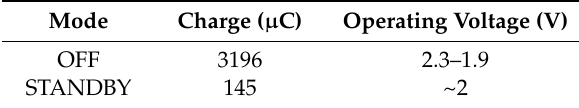
Table 2. Charge requests of node during active states according to mode .